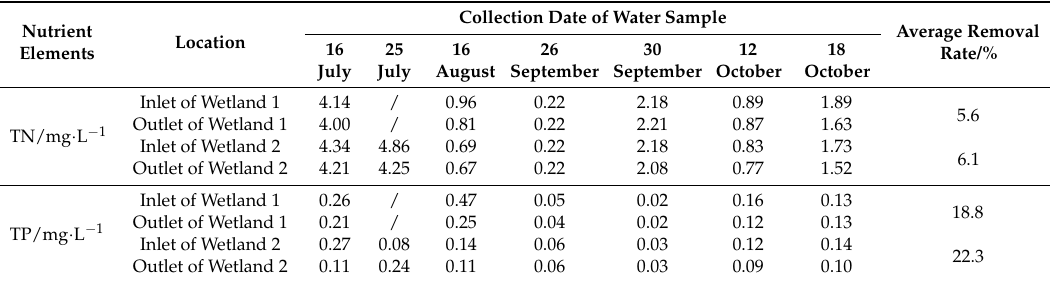
Table 6. Purification of total nitrogen and total phosphorus in pond wetlands during the late rice growth